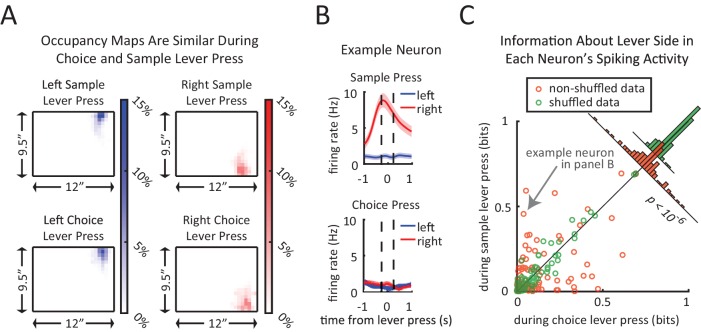
Context-dependent neural encoding of the lever press.(A) Left plots show similarity of head position during left lever press for sample lever press (top) and choice lever press (bottom). Right plots are same as left plots except for right lever press. Average head position occupancy-maps from 250 ms before to 250 ms after the lever press. Occupancy-maps were generated by averaging individual occupancy-maps of all 9 rats (0.5”×0.5” tiles covering the 9.5”×12” chamber). (B) Firing rates of an example neuron during sample lever press and choice lever press. This neuron displays an obvious difference in its encoding of lever side between the sample and choice presses. (C) Neurons differentiate between sample and choice presses in the amount of information conveyed about the lever identity. Each neuron’s information about lever side was calculated by taking the mutual information between lever identity and spiking patterns within a 500 ms time window centered at the lever press (to match time window used in panel A). Orange circles represent sample lever information plotted against choice lever information. Green circles are obtained by recalculating the information after shuffling sample and choice labels for lever presses. Insets are histograms of choice information minus sample information for non-shuffled data (orange) and shuffled data (green). Neurons showed significantly greater difference between sample and choice information than expected by chance (p<10–6; two sample F-test for equality of variance for (sample information – choice information) in shuffled versus non-shuffled data).